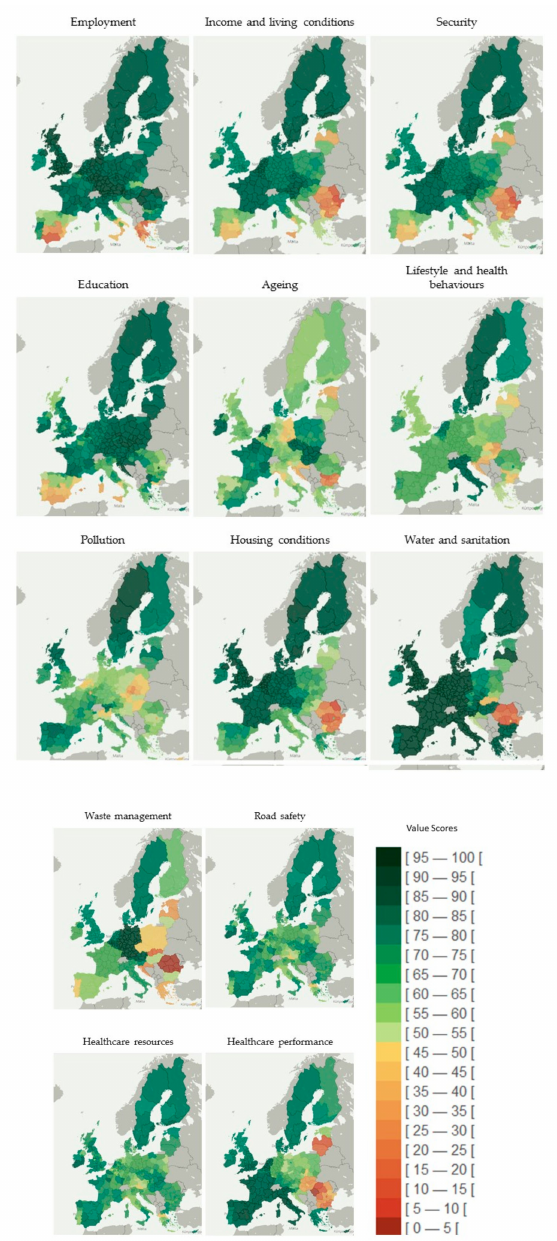
Figure 2. Geographical distribution of the population health index at regional level and across dimensions of health determinants. Note: The regional value-scores are classified in an equal interval scheme. This method divides the values into equal size range considering the minimum and maximum scores (from 0 to 100). The color coding of classes uses a gradation inspired by a tra ffi c light system; red represents worse population health and green represents better